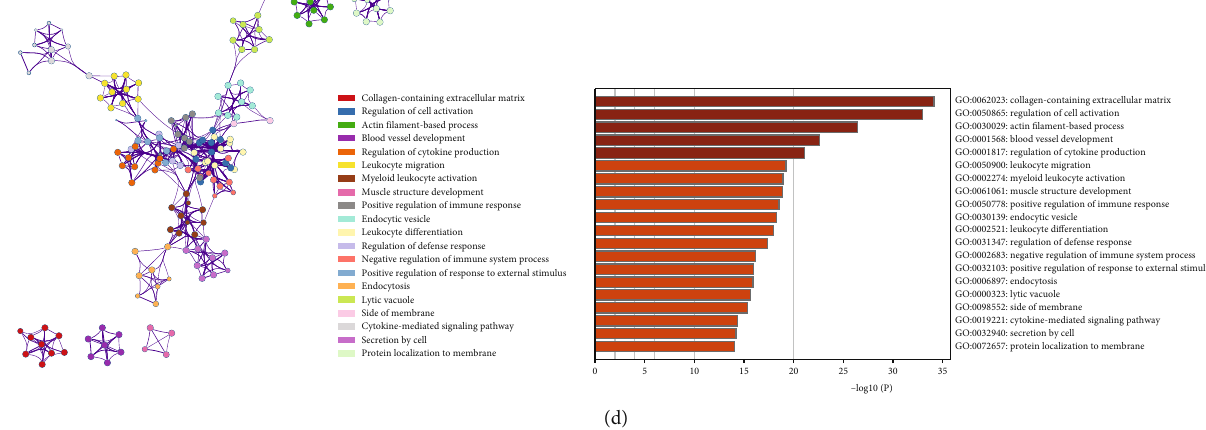
Figure 5: Enrichment analysis of the coexpression genes of PDLIM2. (a) Spearman ’ s correlation analysis showed a correlation between PDLIM2 and di ff erentially expressed genes in prostate cancer. (b, c) Heatmap showing the top 50 signi fi cant genes negatively and positively correlated with PDLIM2 in TCGA-PRAD. (d) Enrichment analysis revealed the biological processes involved in the PDLIM2- related coexpressed